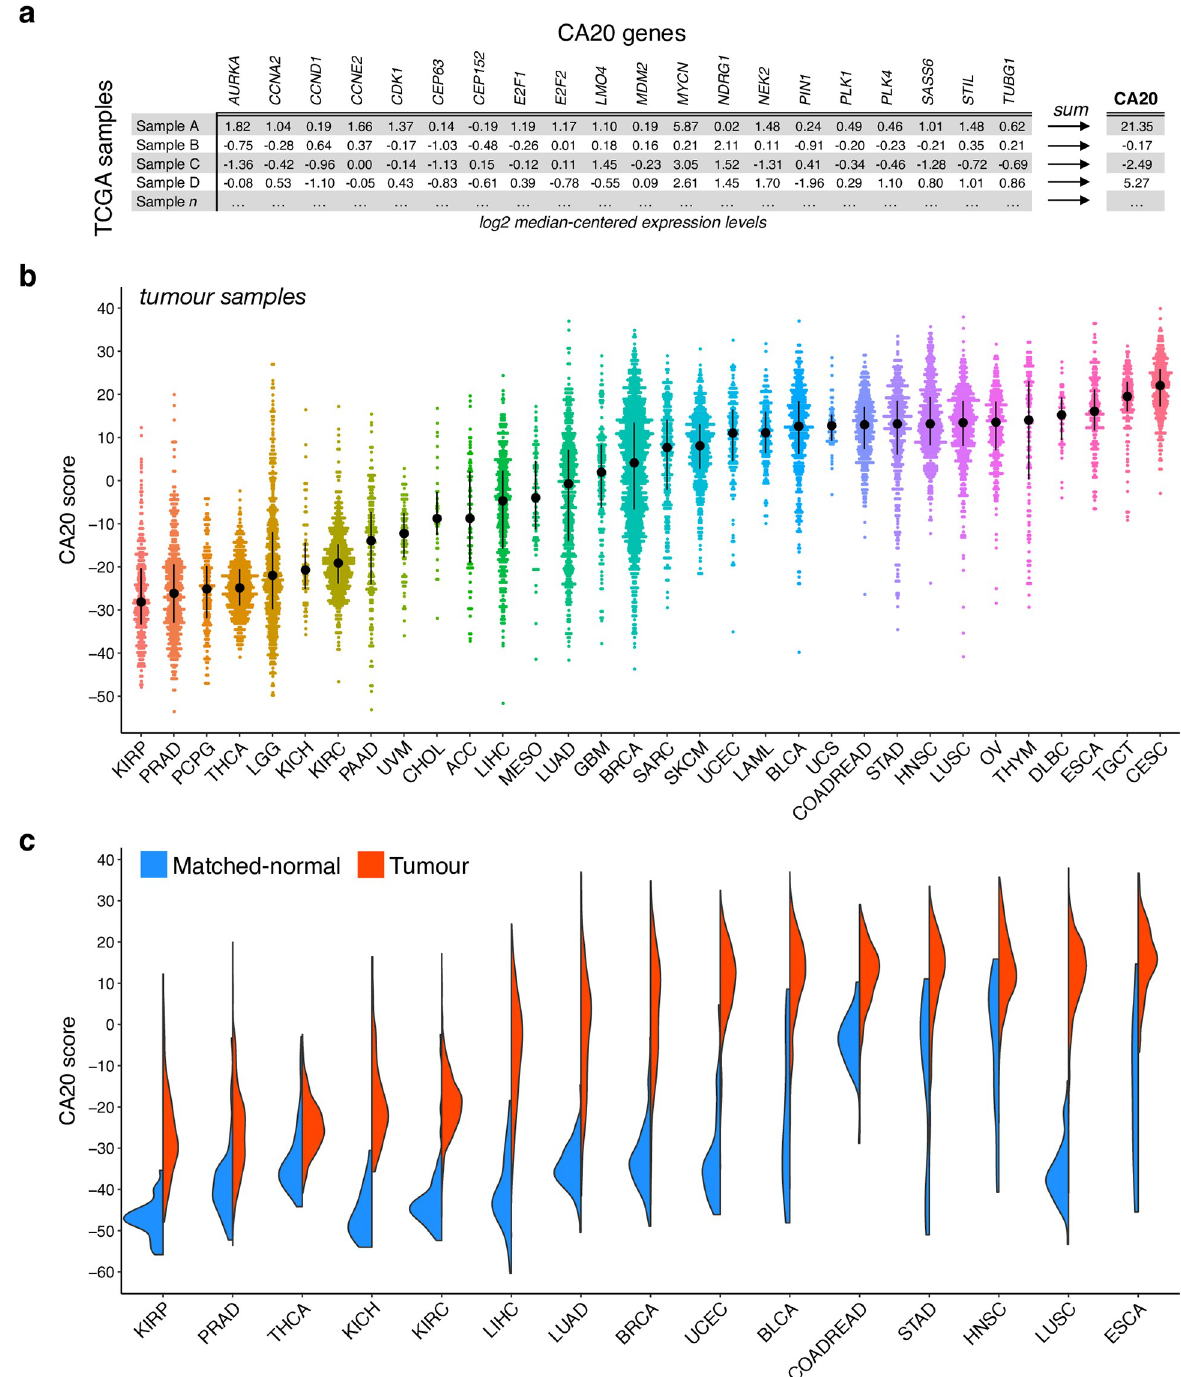
Fig 1. The pan-cancer landscape of centrosome amplification-associated gene expression. ( a ) For each sample, the CA20 score was calculated as the sum of the normalized (log2 median-centred) expression levels of the 20 signature genes. ( b ) CA20 score distribution across tumour samples of all TCGA cancer types. Cohorts are ordered by their median CA20 score. Black points and lines represent the median +/- upper/lower quartiles. ( c ) Tumour samples have higher CA20 levels in all 15 cancers with both tumour and matched-normal samples available (at least 10 samples per sample type; False Discovery Rate (FDR) < 0.0001, Wilcoxon rank-sum test). CA20 score distributions of tumour and normal samples are represented in red and blue, respectively. ACC: adrenocortical carcinoma; BLCA: bladder urothelial carcinoma; BRCA: breast invasive carcinoma; CESC: cervical squamous cell carcinoma and endocervical adenocarcinoma; CHOL: cholangiocarcinoma; COADREAD: colon and rectum adenocarcinoma; DLBC: lymphoid neoplasm diffuse large B-cell lymphoma; ESCA: oesophageal carcinoma; GBM: glioblastoma multiforme; HNSC: head and neck